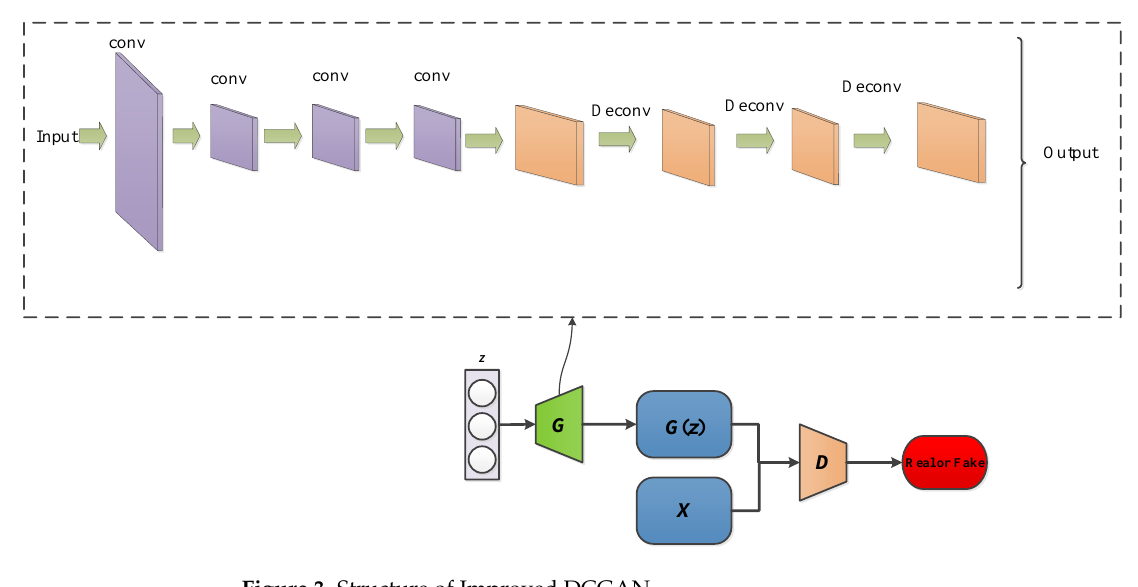
Figure 3. Structure of Improved DCGAN.